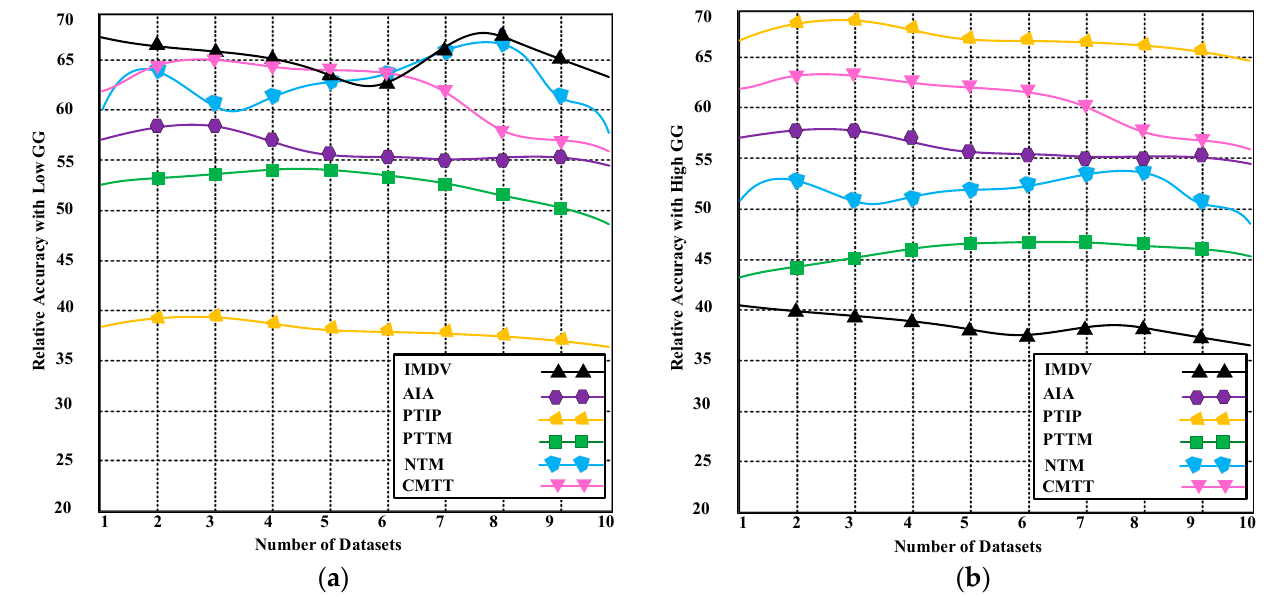
Figure 11. ( a ) demonstrates relative accuracy with low GG; and ( b ) demonstrates relative accuracy with high GG.